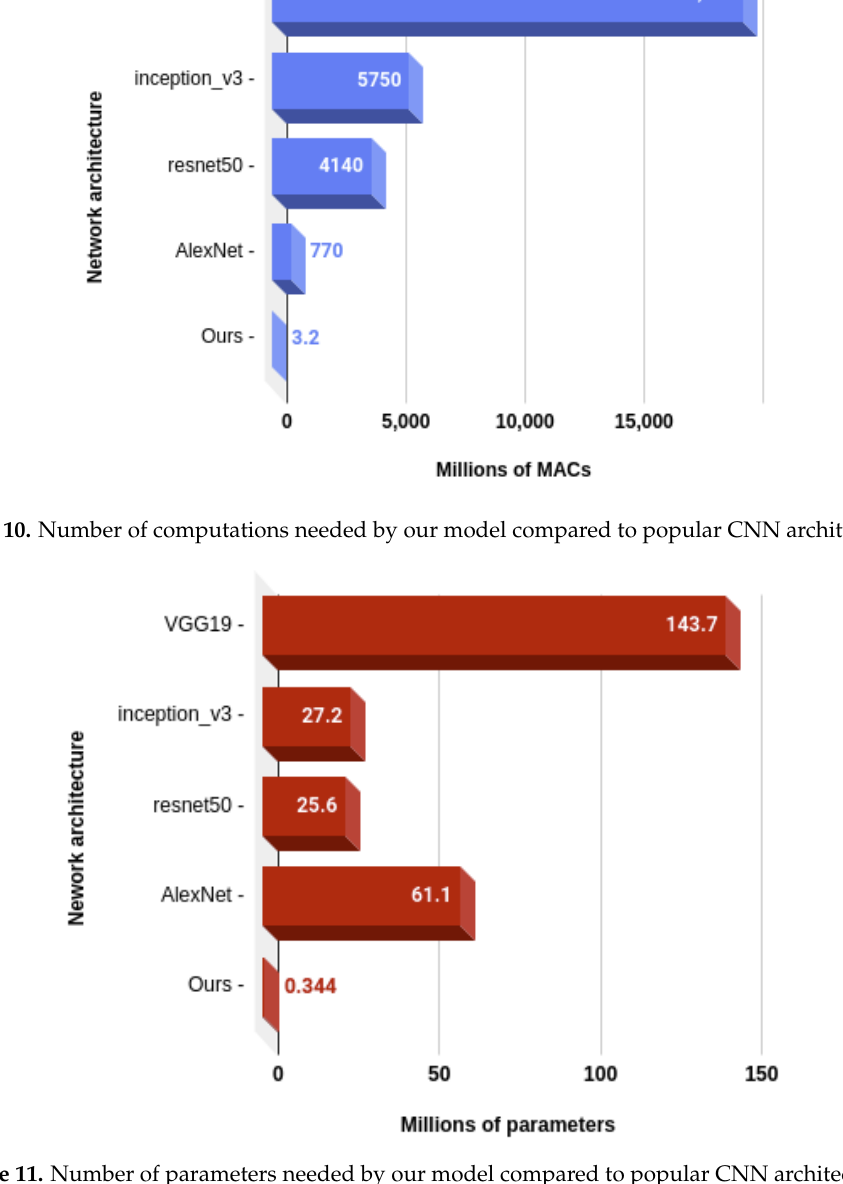
Figure 11. Number of parameters needed by our model compared to popular CNN